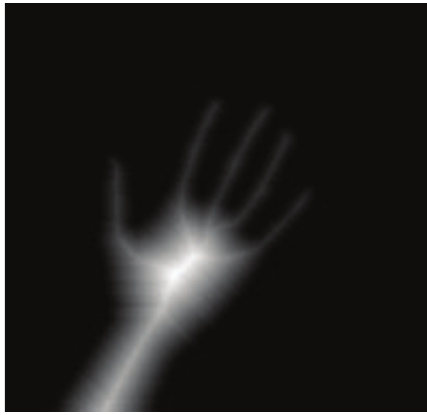
Figure 7: The palm mask.